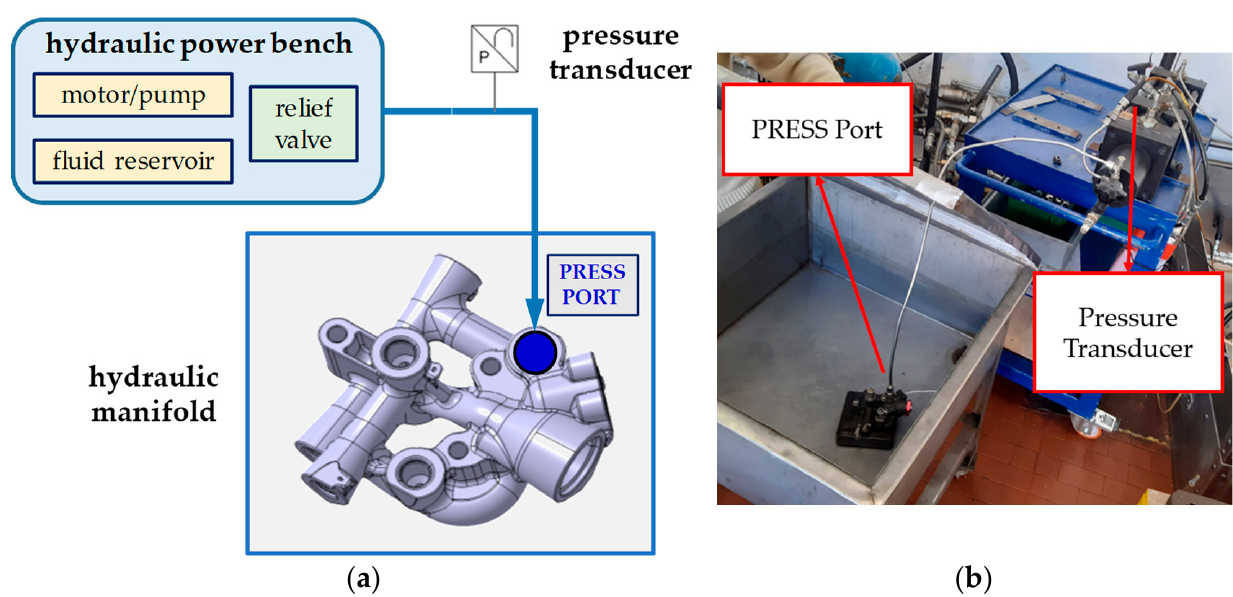
Figure 7. Hydraulic manifold test stand. ( a ) hydraulic layout; ( b ) lab setup.